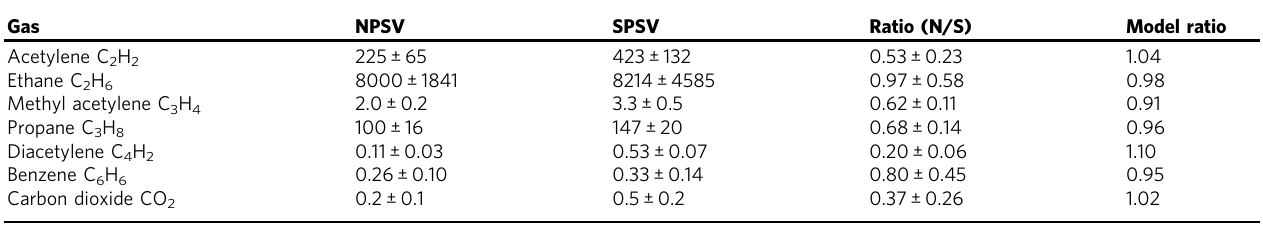
Table 1 Abundances of gases in NPSV and SPSV at 1 mbar (ppbv) compared to the expected ratio from a photochemical model 19 for the same